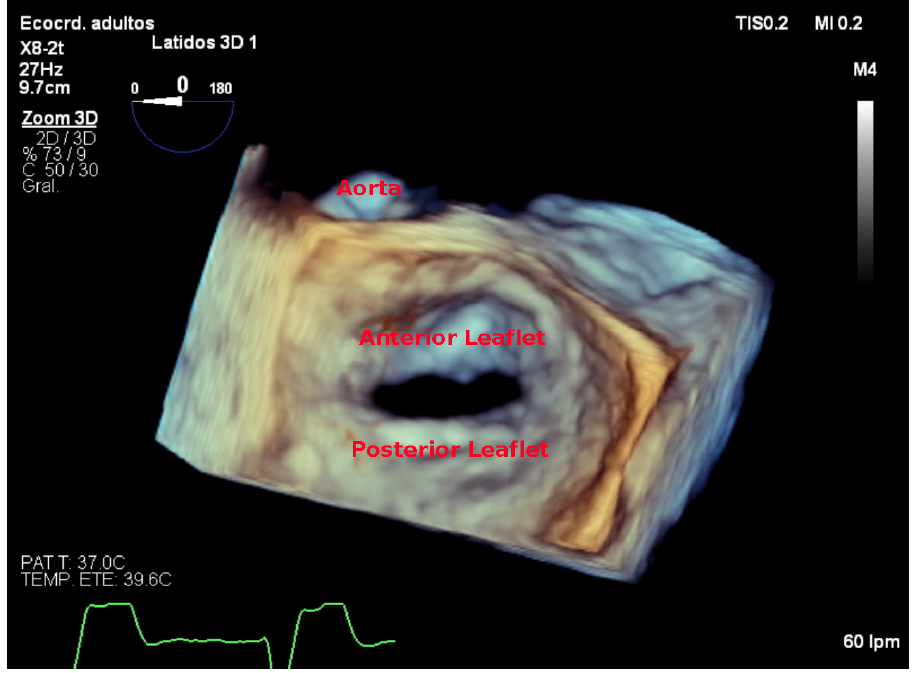
Figure 7. Zoom 3D focused on the mitral valve as view from the left atrium with the aorta placed superiorly (surgical view).